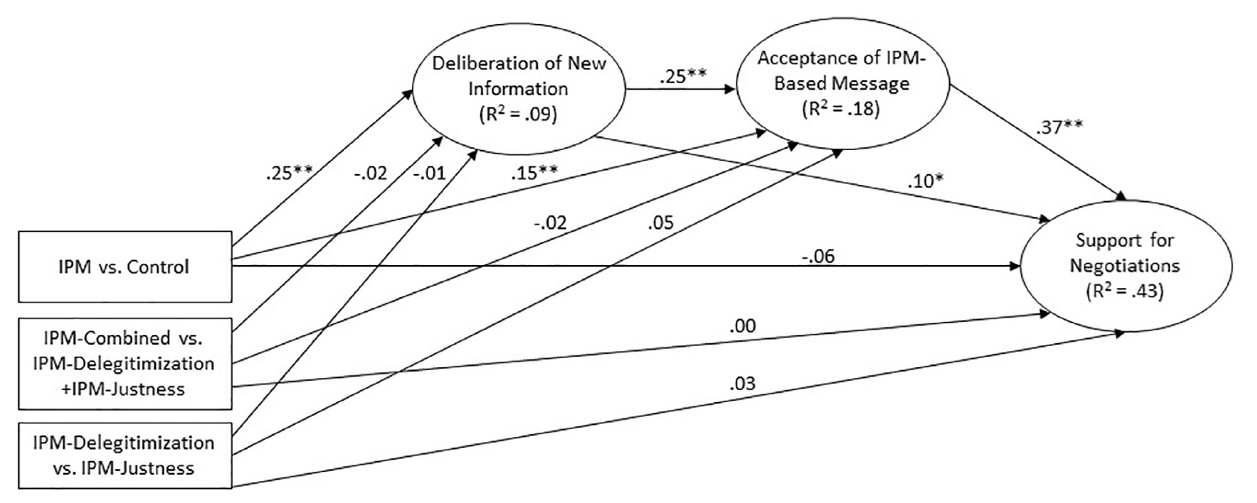
FIGURE 3 | Serial mediation structural model of the effect of the IPM-based intervention on support for negotiation in Study 3. Standardized coefficients are shown. Control variables (political orientation, gender, age), error terms and indicators are not shown. Full information is available in the Supplementary Materials . All coefficients correspond to the arrows beneath them. ∗ p < 0.05 ∗∗ p <